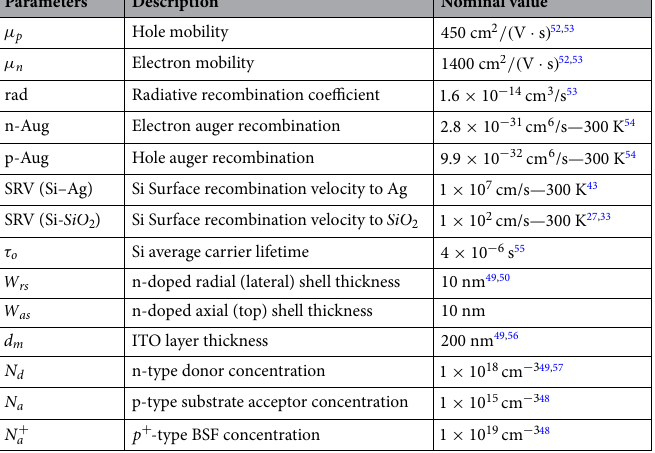
Table 2. The electrical and geometrical parameters of the proposed design in the core–shell junction.